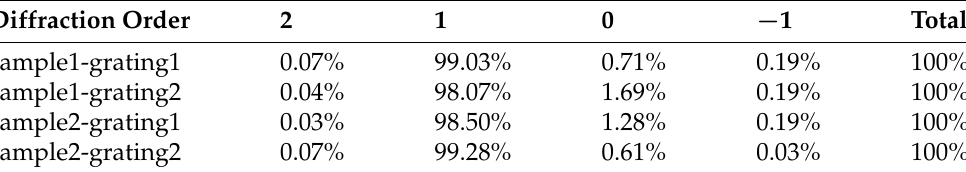
Table 1. The efficiency of the